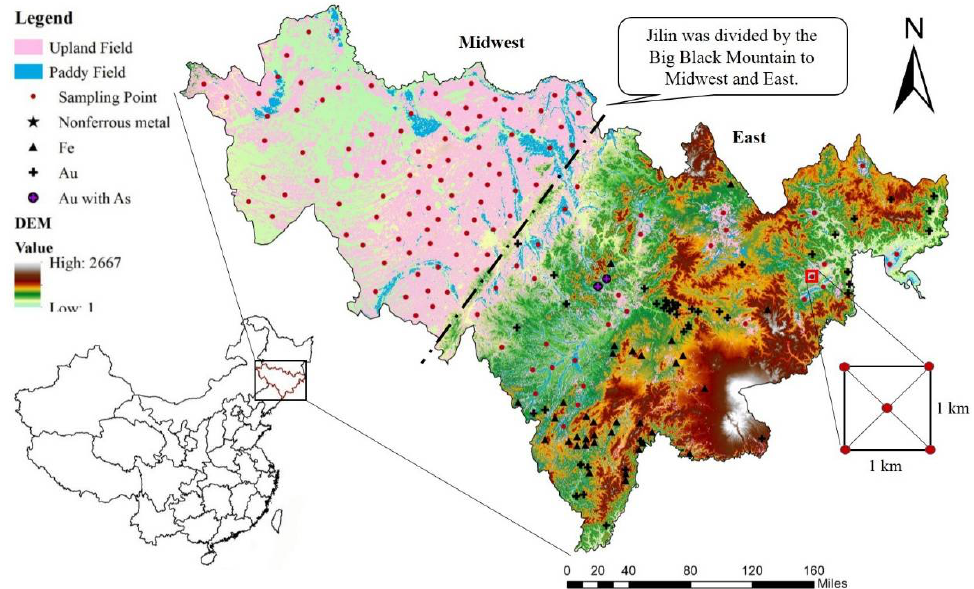
Figure 1. Study area and the distribution of the soil samples in the farmland.